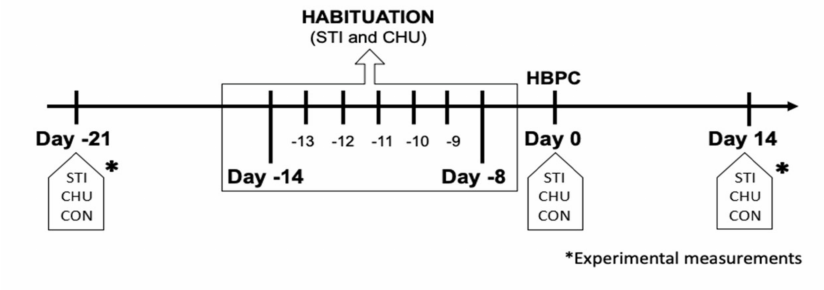
Figure 1. Timeline of the experiment activities at the Beef Cattle Center, relative to the start of the halter breaking practice class (HBPC). The habituation occurred on seven consecutive days Day − 14 to − 8) for the chute (CHU) and stimulated (STI) group. The Control group (CON) did not receive any habituation or handling prior to